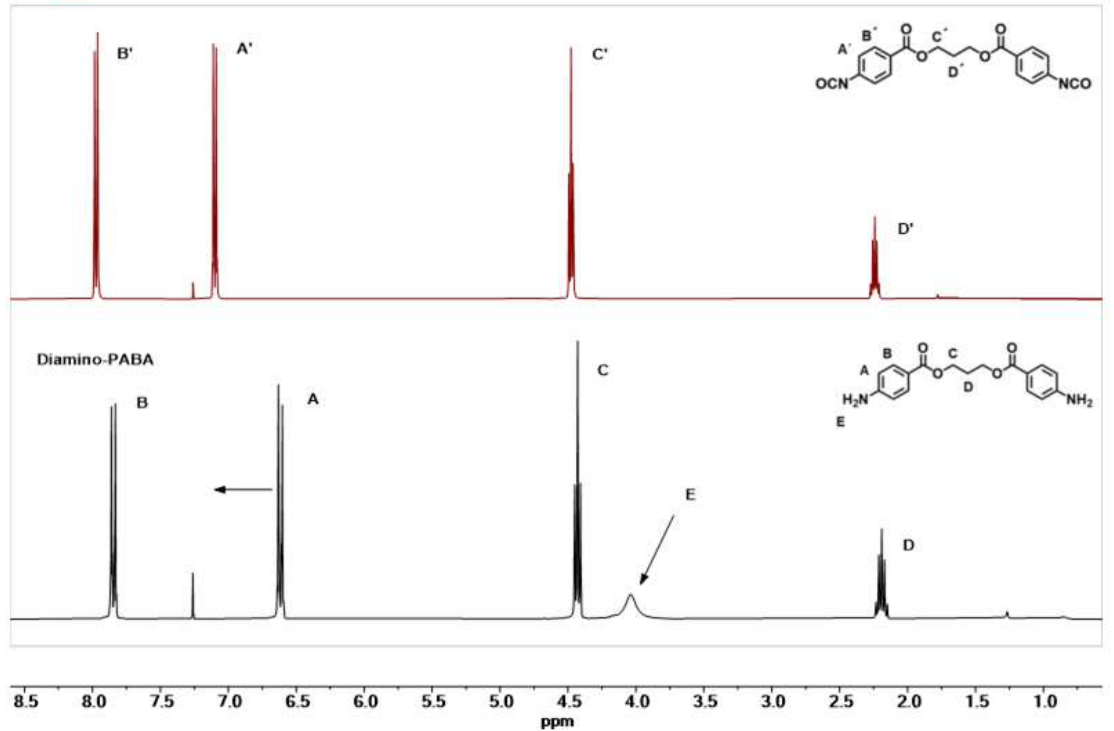
Figure 1. Comparison of 1H-NMR spectra in CDCl 3 of diamino-PABA (in black) and isoPABA products (in